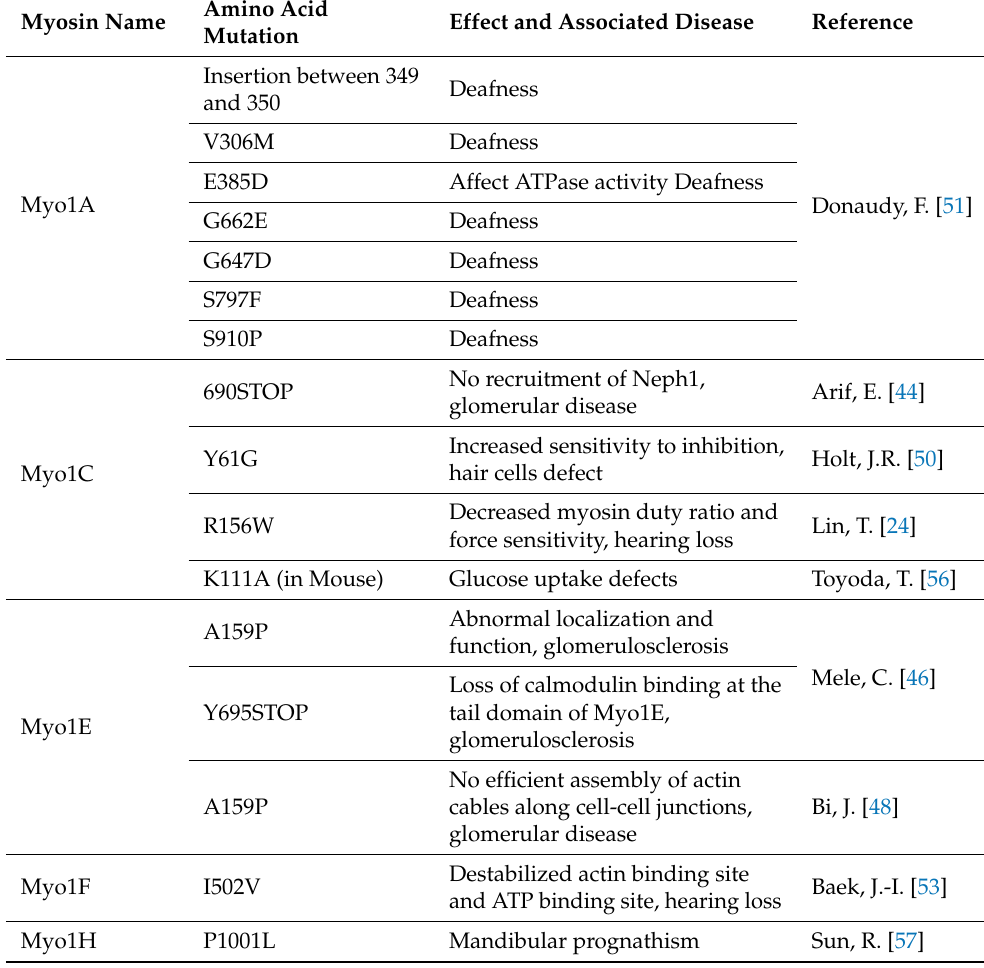
Table 2. Diseases associated with myosin 1 paralog mutations.